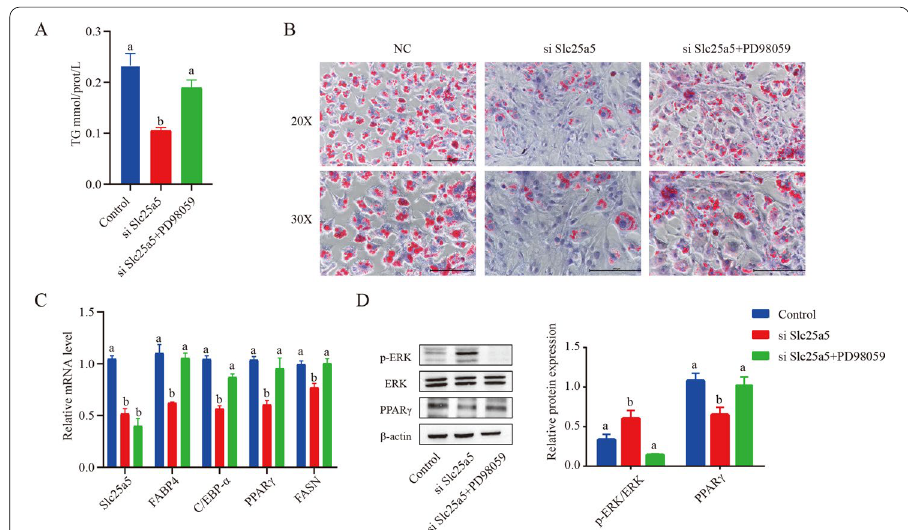
Fig. 5 ERK inhibitor reverses Slc25a5 knockdown-induced adipogenesis inhibition. Before adipogenic differentiation was induced, OP9 cells were transfected with Slc25a5 siRNA, and 24 h later, these cells were incubated with 1 mM rosiglitazone and PD98059 (50 μM). A Cellular triglyceride (TG) levels were measured. B Oil Red O staining was performed after adipogenic differentiation, and the results were visualized by light microscopy. The scale bar is 200 µm. C RT–qPCR was performed to assess the expression of the adipogenic factors PPARγ , FABP4 , FASN , and C/EBPα after adipogenic differentiation. D Protein levels of ERK, p-ERK,